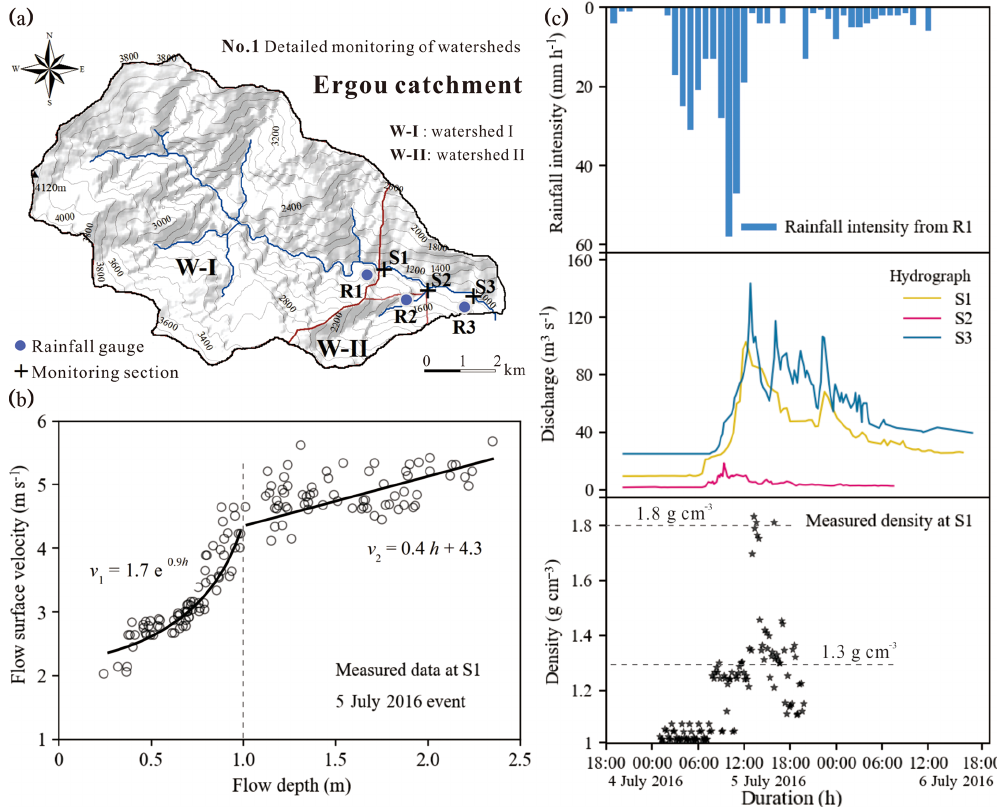
Figure 13. Data analysis of the debris flow which occurred on 5 July 2016 (Fig. 12) in Er (CID W7, Wenchuan County; no. 1 in Fig. 1c; Cui et al., 2018). (a) Map of the catchment, (b) flow surface velocity vs. flow depth, and (c) rainfall intensity, flow discharge and flow